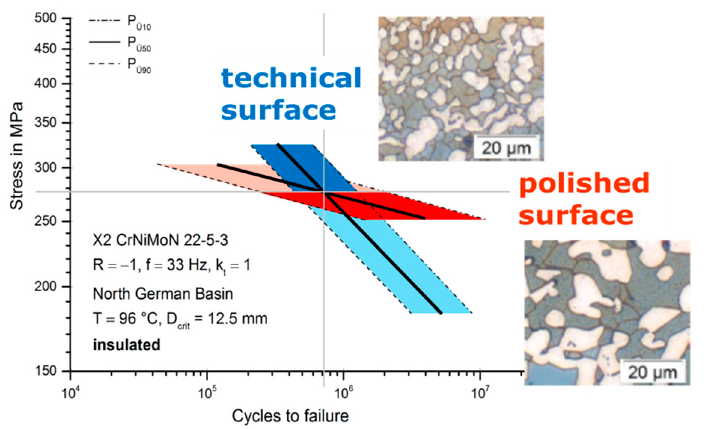
Figure 15. Influence of surface finish quality and local corrosion initiation on CF, S-N curves, and insulated test setup. ( Top right ): Turned, ( bottom right ): Polished.